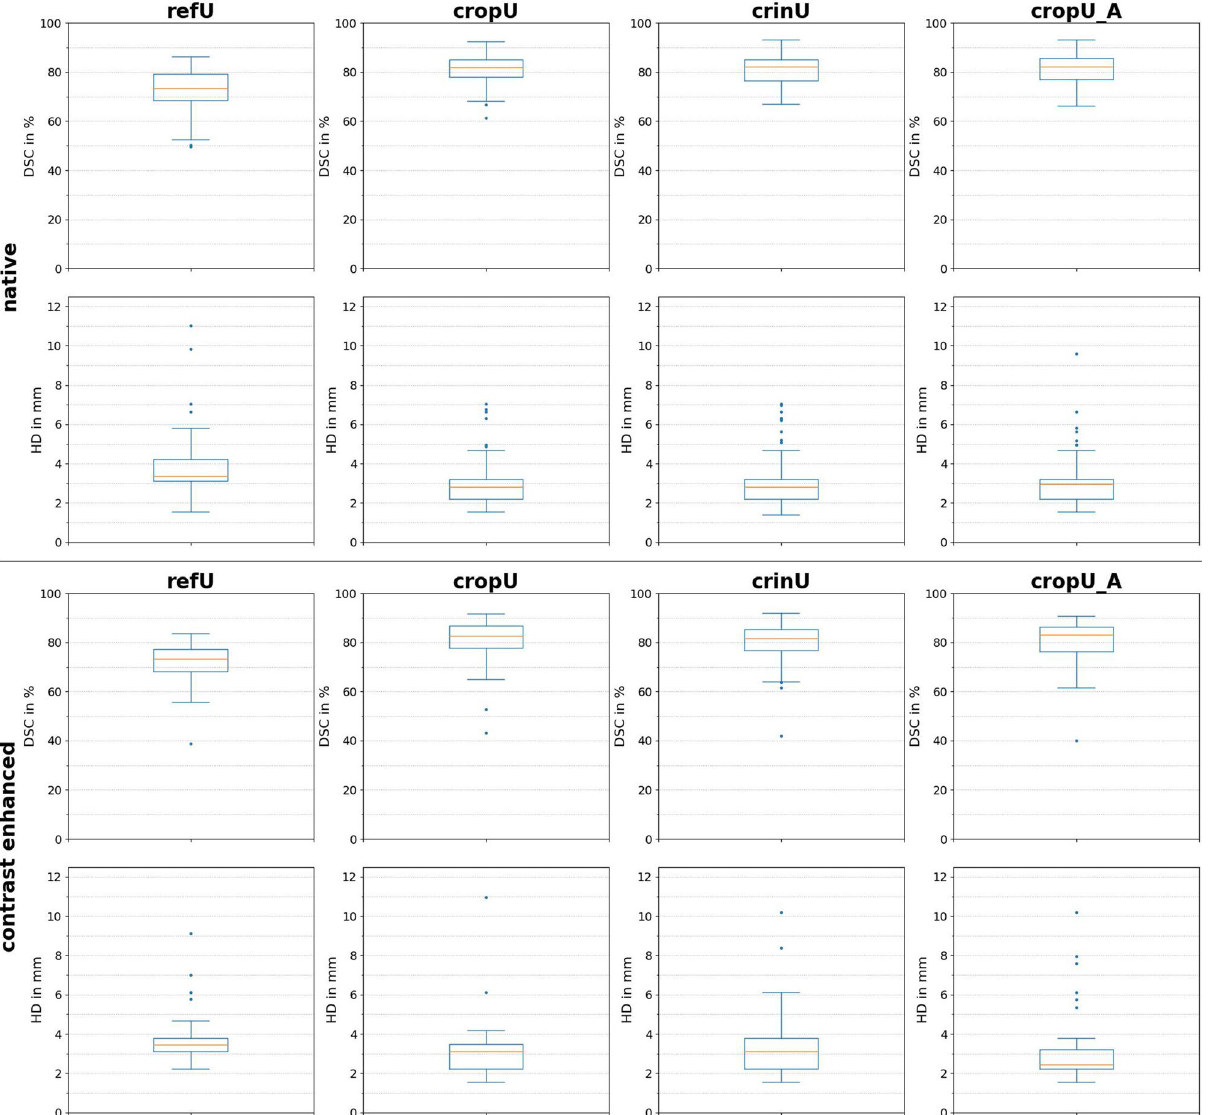
Figure 4. Geometric results of the automated segmentation. The first column shows the geometric results for refU, the second column for cropU, the third column for crinU and the fourth column for cropU_A. The upper block corresponds to native and the lower block to contrast enhanced data; respectively in each block the first row shows the boxplots of the Dice Similarity Coefficient (DSC) and the second row shows the boxplots of the Hausdorff Distance